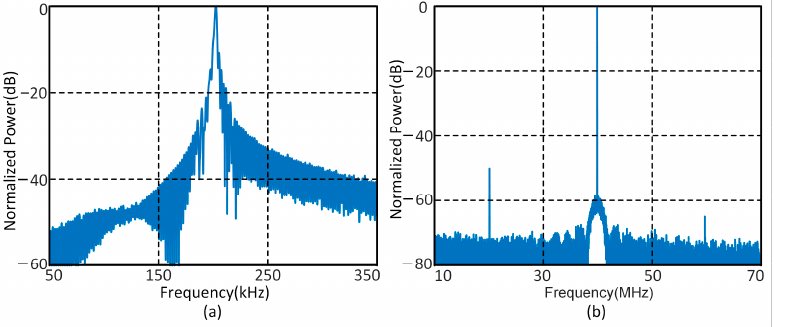
Figure 3. The normalized power spectrum density of the de-chirped signal ( a ) and the down-converted signal ( b ).